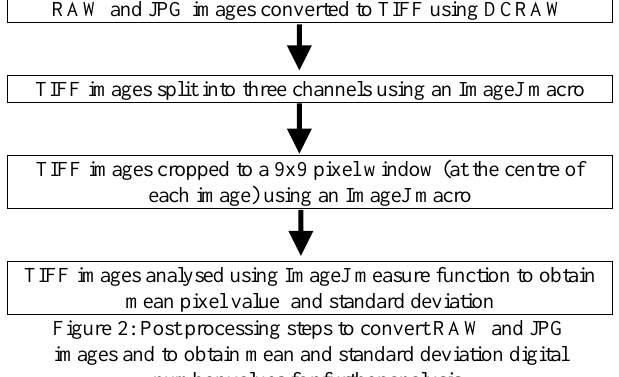
Figure 2: Post processing steps to convert RAW and JPG images and to obtain mean and standard deviation digital number values for further analysis.